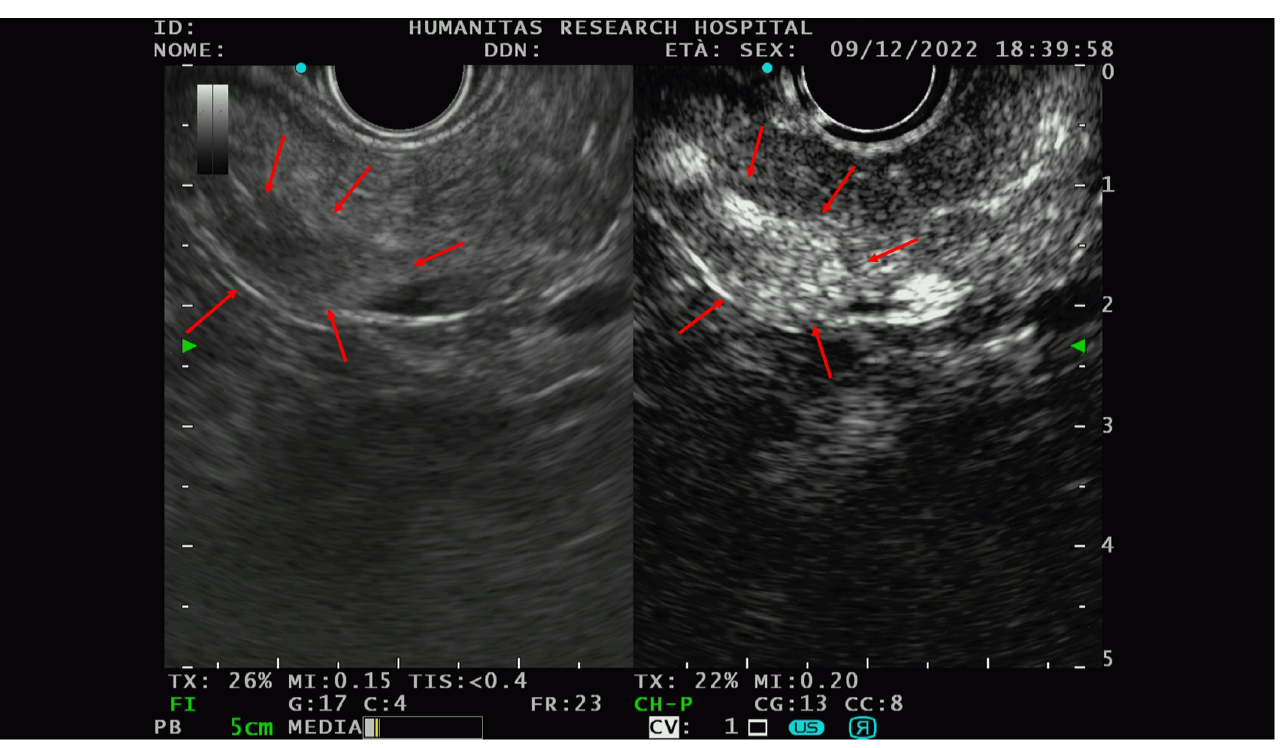
Figure 3. An example of the PNET EUS appearance with and without contrast (Sonovue). In the right picture, there is a hypo-isoechoic lesion while in the picture on the left, the hyperenhancement of the same lesion could be appreciated after intravenous contrast administration. Red arrows delineate the edge of the lesions. After FNAB, the solid lesion was characterized as G1-PNET.